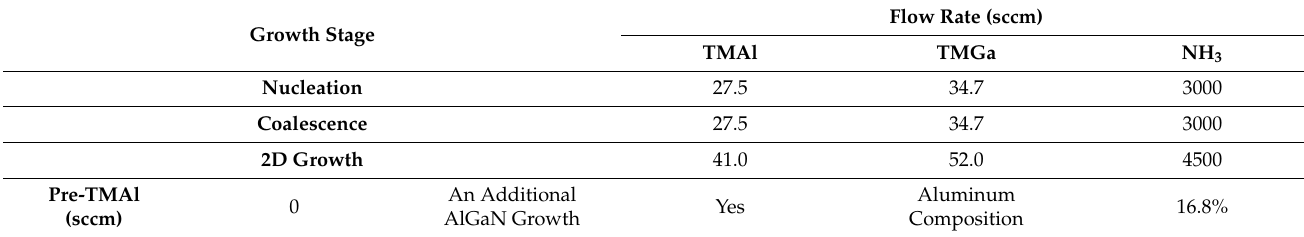
Table 2. The growth parameters of sample